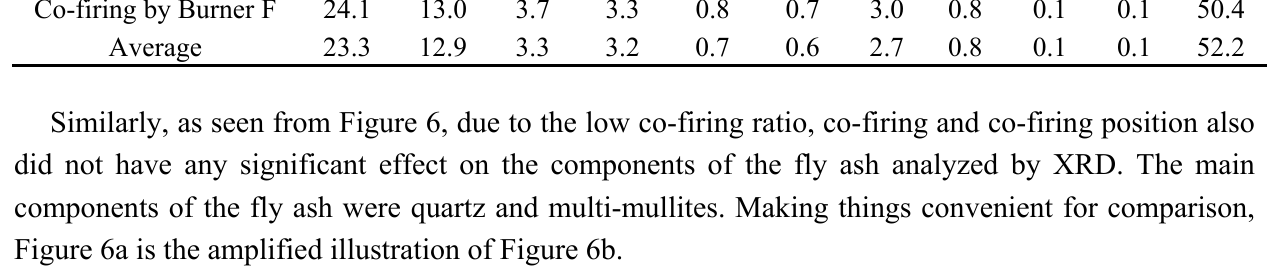
Figure 6. XRD (X-ray diffraction) analyzed results of fly ash. ( a ) Amplified illustration; ( b ) Original